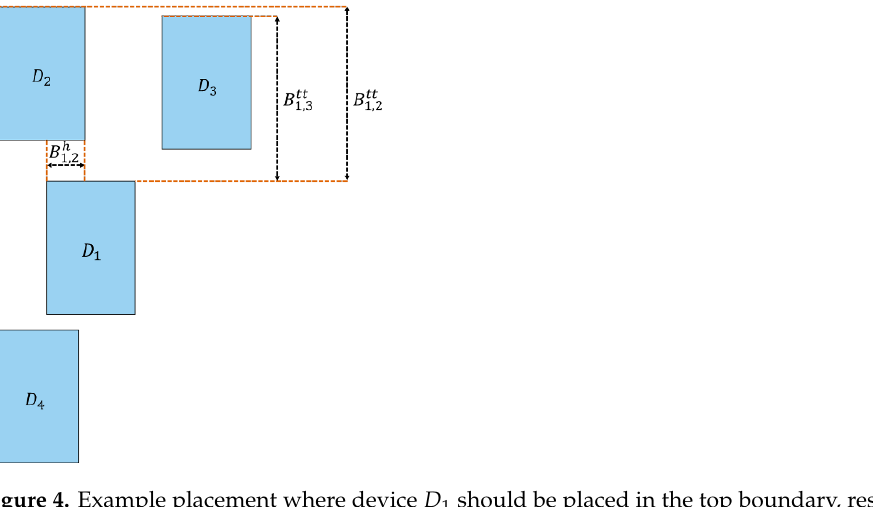
Figure 4. Example placement where device 𝑫 𝟏 should be placed in the top boundary, resulting in three distinct errors 𝐵 1,2𝑡𝑡 , 𝐵 1,3𝑡𝑡 , and 𝐵 1,2ℎ . Note that no error exists between 𝑫 𝟏 and 𝑫 𝟒 despite the existing horizontal overlap between them since 𝑫 𝟒 is not closer to the top boundary than 𝑫 𝟏 .